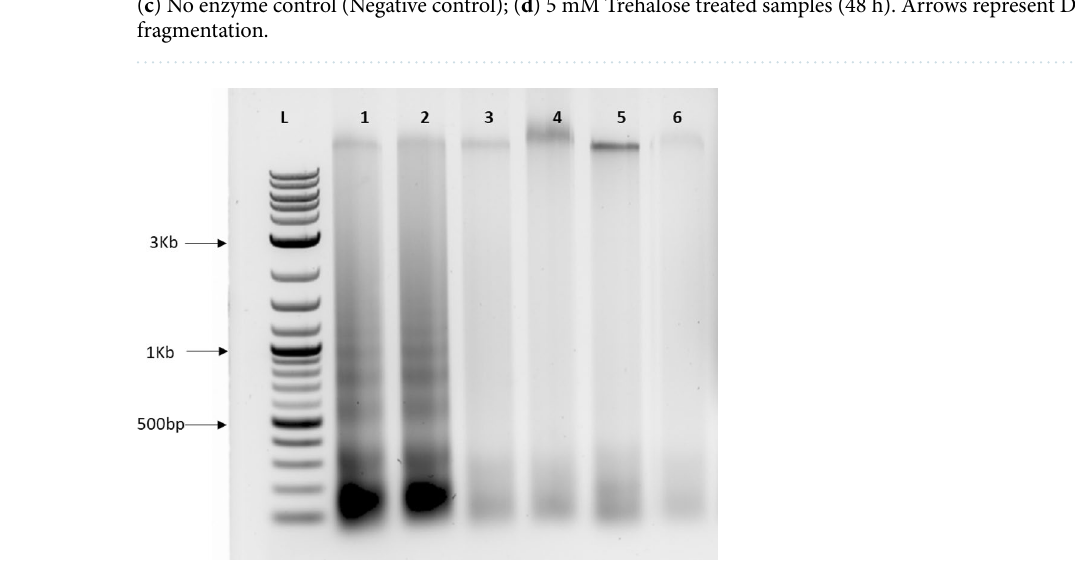
Figure 4. Stachyose treatment induced TUNEL positive nuclei in N. benthamiana . TUNEL Assays were done on sugar treated Nicotiana benthamiana triplicate biological replicates to detect apoptotic-like cell death. N. benthamiana samples treated with DNAse were used as positive controls as DNAse induces nuclei fragmentation. ( a ) 5 U/μl DNase treated samples (positive control); ( b ) 3.2 mg/ml Stachyose treated samples;